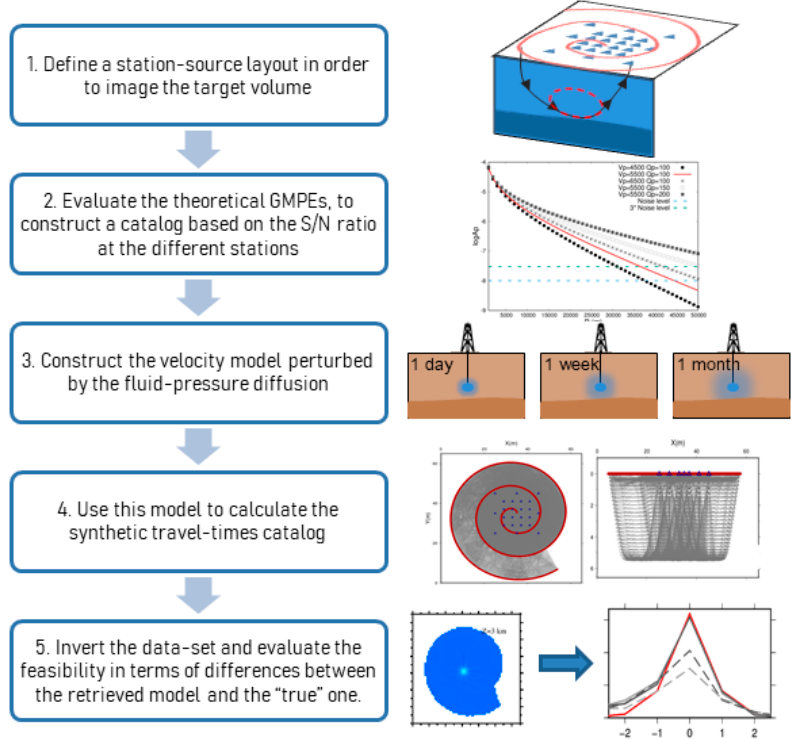
Figure 2. A block diagram of the feasibility study.